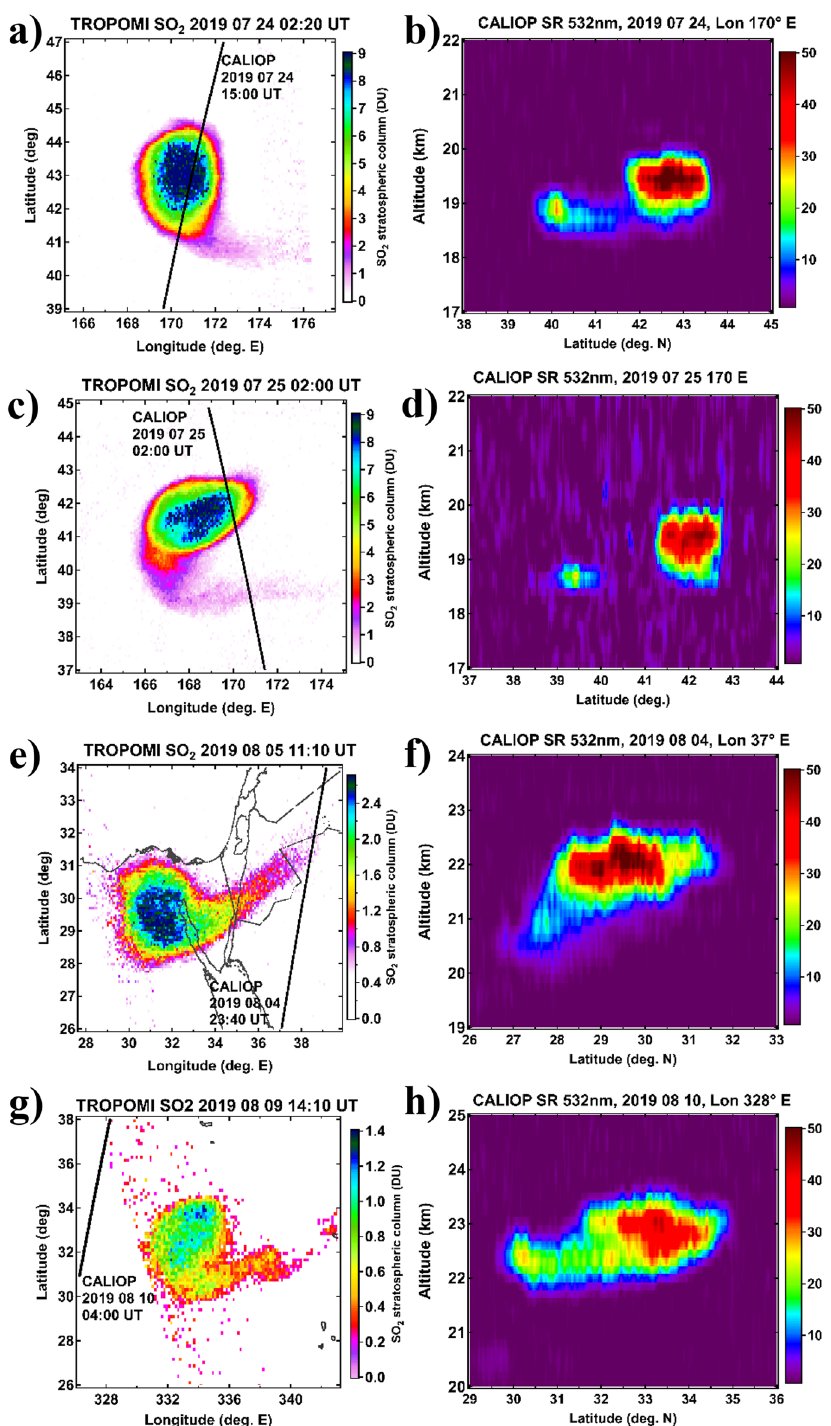
Figure 2. Horizontal and vertical structure of the primary VVP (vorticized volcanic plume). Left column (panels a,c,e,g ): selected TROPOMI SO 2 maps revealing the comma-shaped rotating plume. The nearest CALIOP orbit with indication of date/time is shown as black curve. Right column (panels b,d,f,h ): corresponding CALIOP scattering ratio cross-sections through the plume. Panels a,f,h show CALIOP nighttime measurements that are more than 10 h apart from TROPOMI sampling. Panel d shows CALIOP daytime measurement precisely matching TROPOMI in